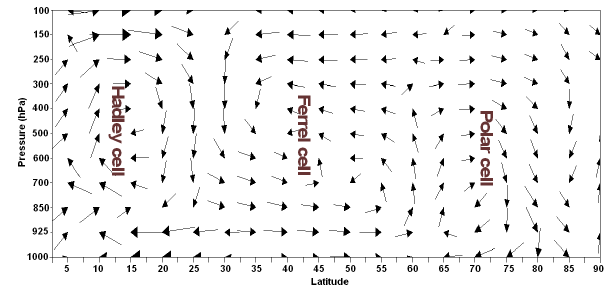
Fig. 2. Vertical profile of vector winds, derived from zonally aver- aged meridional wind (ms − 1 ) and vertical velocity (ms − 1 ), span- ning from equator to North Pole, averaged over springs from 1950 through 1980 and over the Northern Hemisphere. In presentation, vertical velocity has been multiplied by